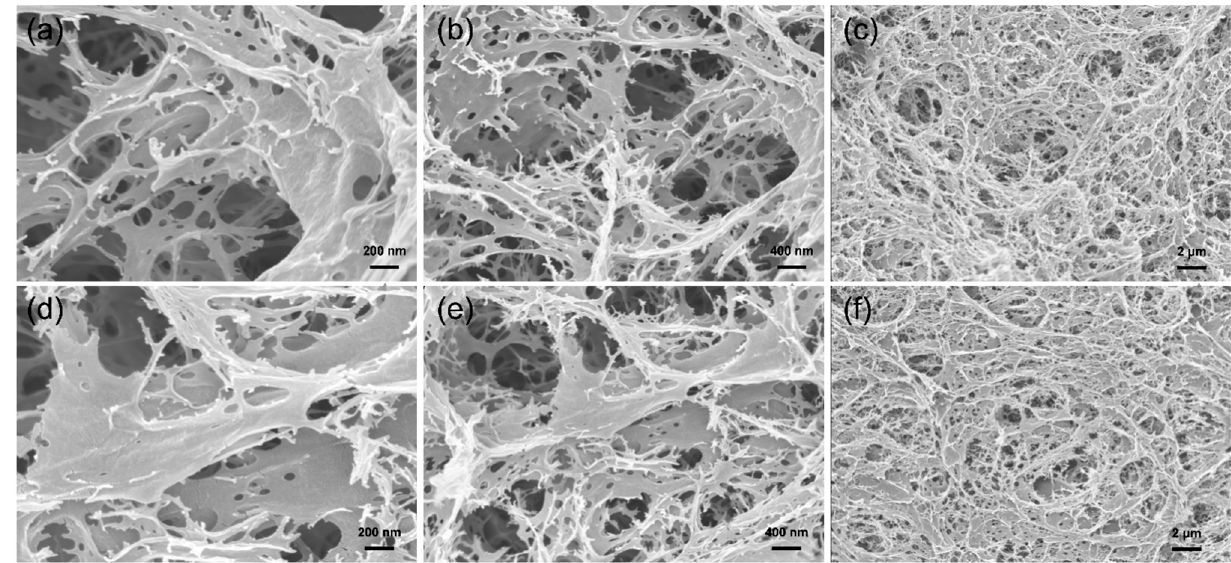
Figure 5. SEM images of the gel sample (CHPVA-5-0.5: ( a ) 100,000×, ( b ) 50,000×, ( c ) 10,000×; CHPVA- 4-0.5: ( d ) 100,000×, ( e ) 50,000×, ( f ) 10,000×).